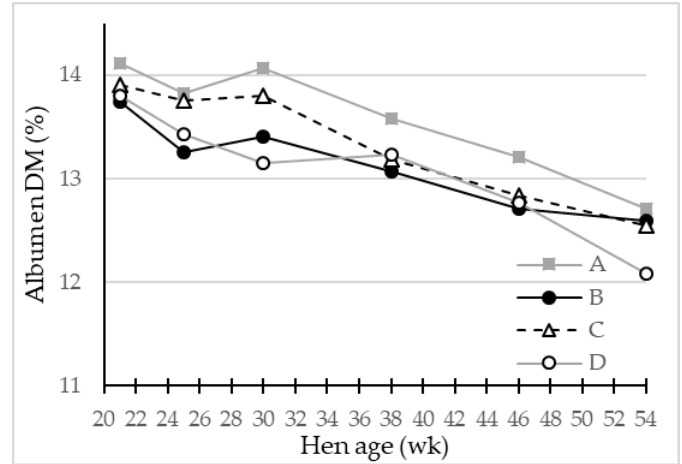
Figure 5. LS-means of egg albumen dry matter (DM) (%) in eggs from four different hen genotypes (A – D) as function of hen age (week) ( p < 0.05), n = 30 for genotype A and 45 for genotypes B, C and D.